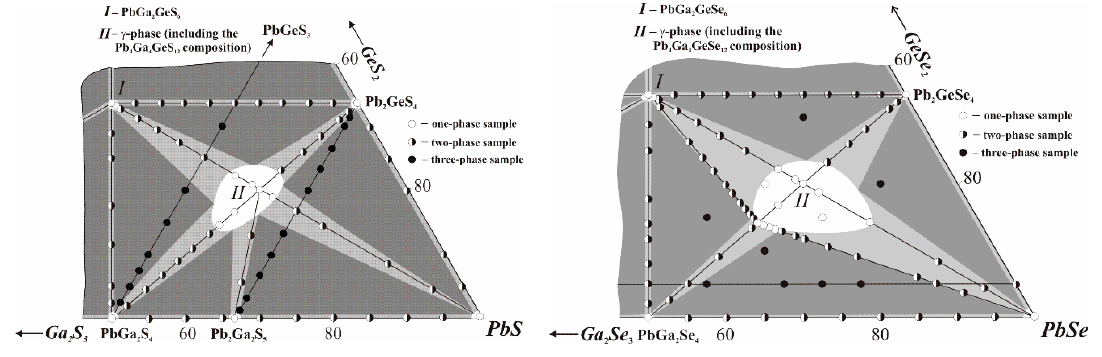
Figure 1. Isothermal sections of the PbS(Se) − Ga 2 S(Se) 3 − GeS(Se) 2 systems in the PbS(Se) − Pb 2 GeS(Se) 4 − PbGa 2 GeS(Se) 6 − PbGa 2 S(Se) 4 part at 670 K.